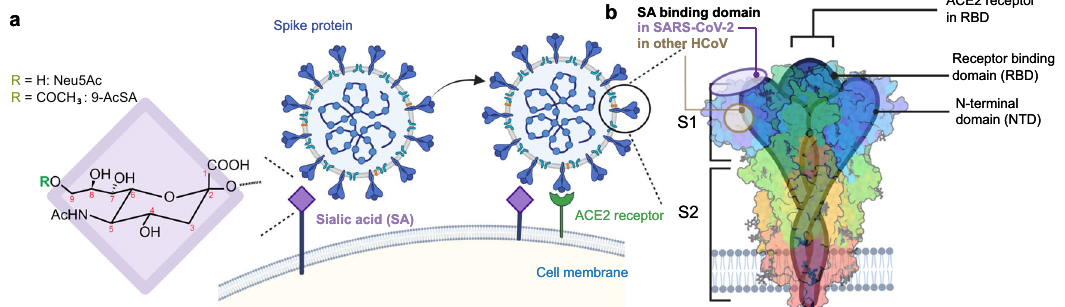
Fig. 1 SARS-CoV-2 binding to cell surface receptors. a SARS-CoV-2 spike protein interacts with both cell surface sialic acids and ACE2 for virus cell entry. The sialic acid family includes many derivatives of the nine-carbon sugar neuraminic acid. The N -acetyl-neuraminic acid (Neu5Ac) and 9-O-acetylated sialic acid (9-AcSA) are presented here. The S glycoprotein is composed of two subunits, S1 and S2, and is commonly represented as a sword-like spike. b Protein structure model of SARS-CoV-2 S protein showing the RBD binding domain for ACE2 receptor on top and the fl at, non-sunken sialic acid-binding domain for host cell surface sialic acid-binding (purple circle) (PDB ID: 6VXX). The groove-like, sunken SA-binding domain in other human coronaviruses (HCoV) is highlighted in the brown circle. Created with